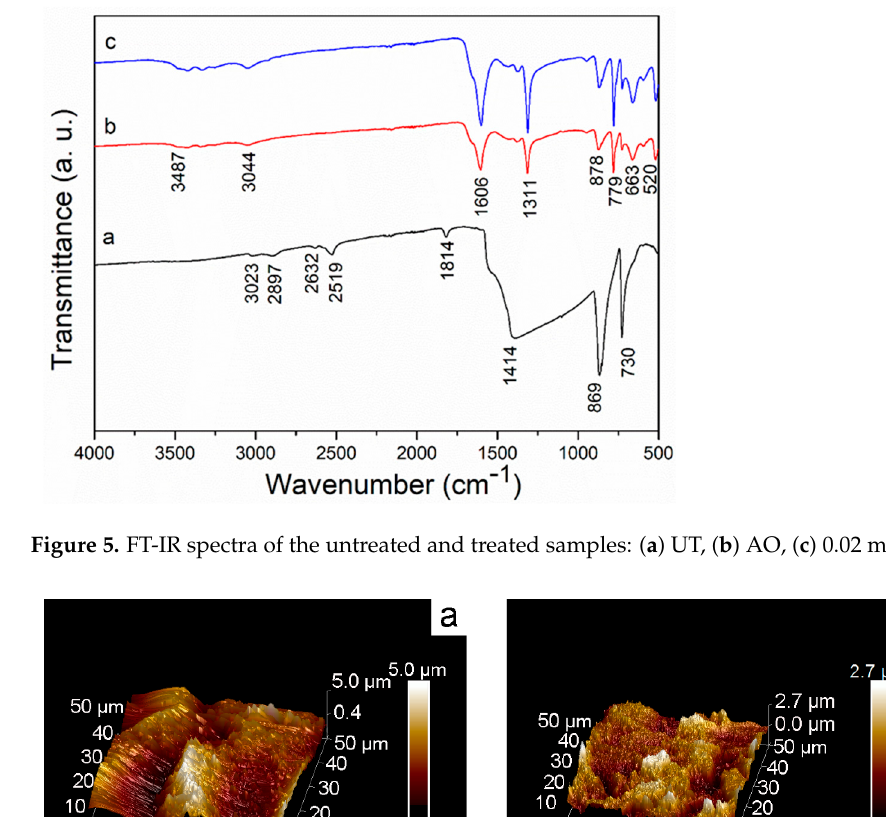
Figure 5. FT ‐ IR spectra of the untreated and treated samples: ( a ) UT, ( b ) AO, ( c ) 0.02 mol/L CA.